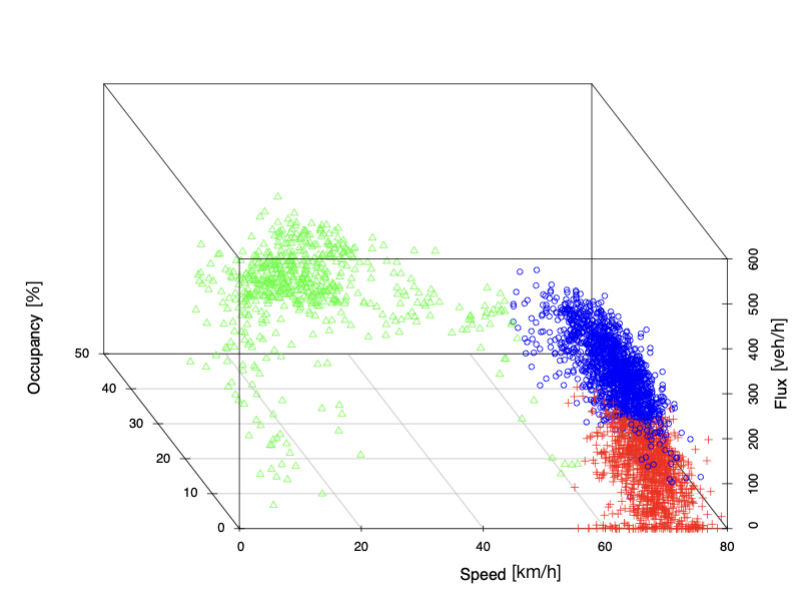
Figure A4. 3D plot of clustered Las Vegas data. The data from Sophia Antipolis also demonstrate the existence of the Free Choice phase. These two datasets both have a wide range of observed speeds at low levels of occupancy, as shown in the pairs plots and 3D plots in Figures A5 and A6.